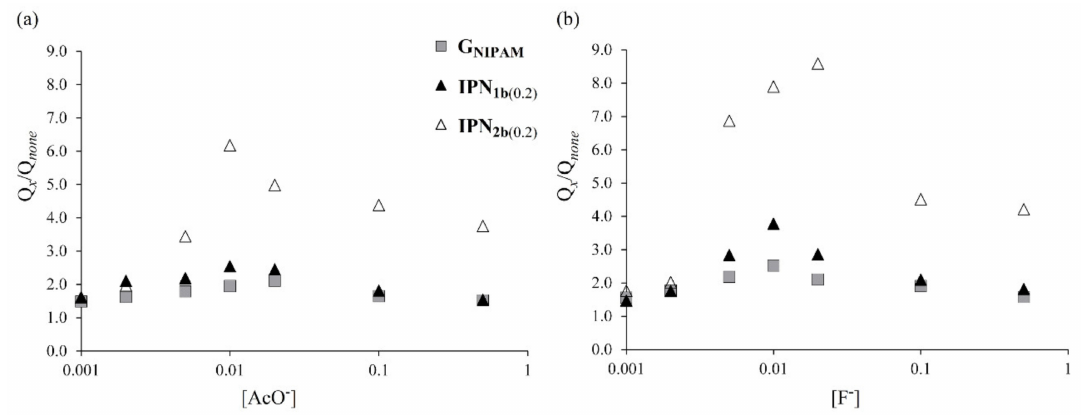
Figure 7. Log plots of relative swelling degree ratio ( Q x / Q none ) of G NIPAM (Table 2, run 1), IPN 1b(0.2) (run 6), and IPN 2b(0.2) (run 10) vs. concentrations (mol / L) of ( a ) acetate and ( b ) fluoride anions in DMF (25 ◦